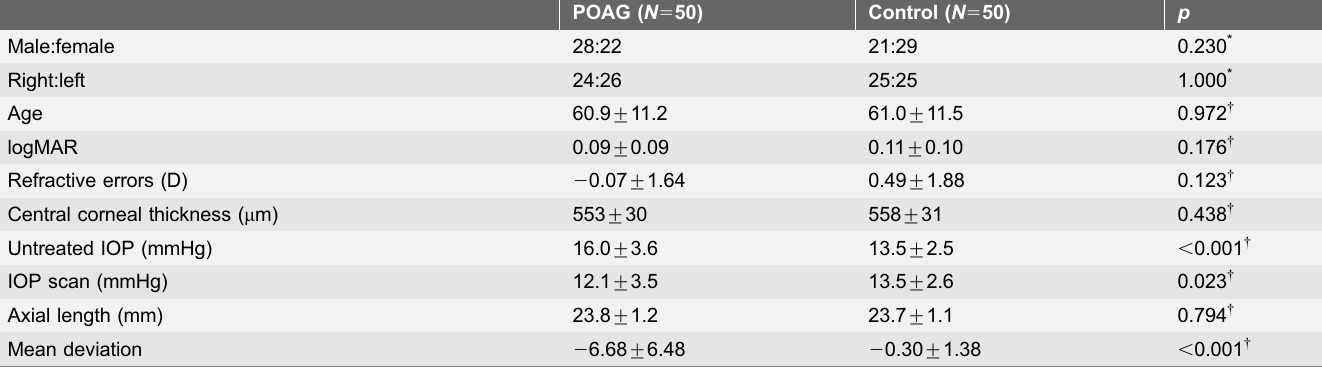
Table 1. Characteristics of the patients with primary open-angle glaucoma (POAG) and the normal healthy (control) subjects. POAG ( N 5 50)